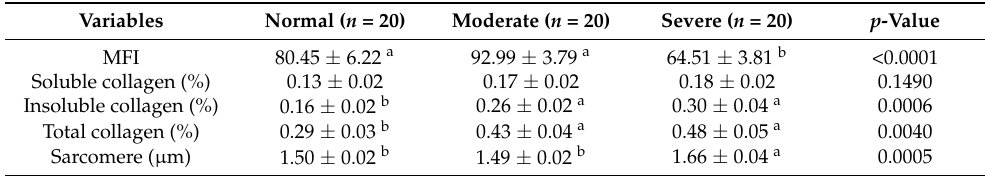
Table 4. Mean values and standard deviation of the myofibrillar fragmentation index (MFI), collagen and sarcomere length of breast meat from broilers affected by WBM.